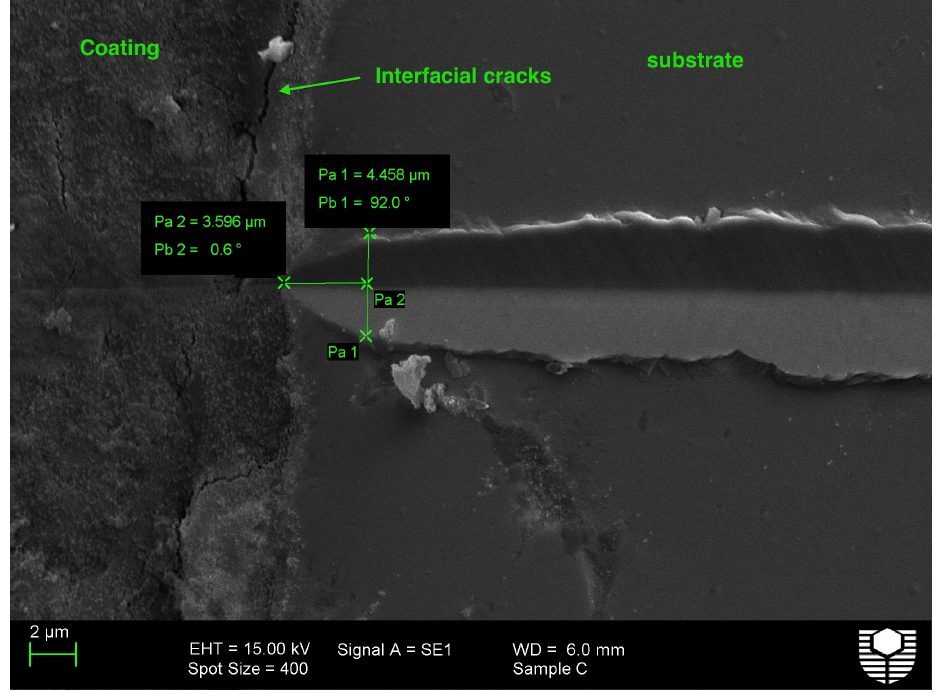
Figure 6. SEM image showing cone formation (coating thickness: 900 m).